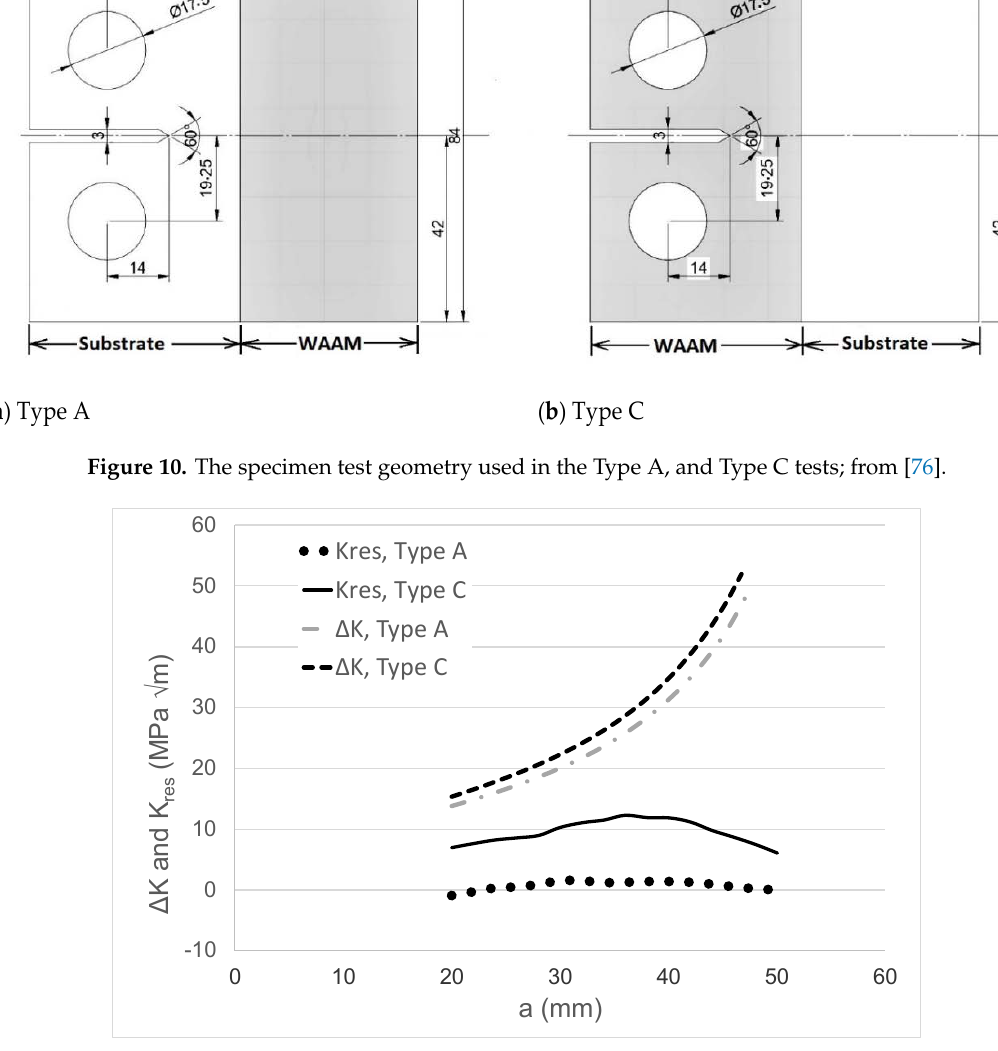
Figure 11. The relationship between the residual stress intensity factors and the crack length ( a ) as determined in [76] for the Type A and Type C specimens.